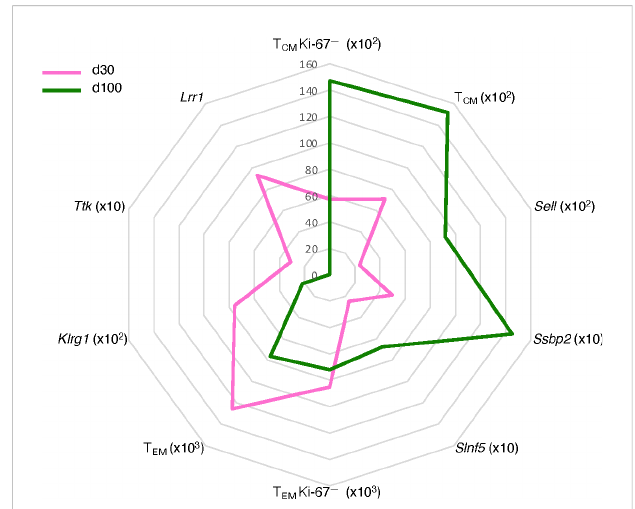
FIGURE 6 Schematic of “ quiescent-but highly responsive ” memory spleen CD8 T cell signature. Spider plot representing key features of splenic signature of gag-speci fi c CD8 T cells at d30 (pink) and d100 (green) post-prime. Units of measure are the following: absolute cell numbers in the spleen for T CM , T EM , Ki-67 — TCM, and Ki-67 — TEM gag-speci fi c CD8 T cells (see Figures 2E, F, 3E, F); mean DESeq2-normalized counts for Sell, Ssbp2, Slnf5, Klrg1, Ttk, and Lrr1 (see Figure